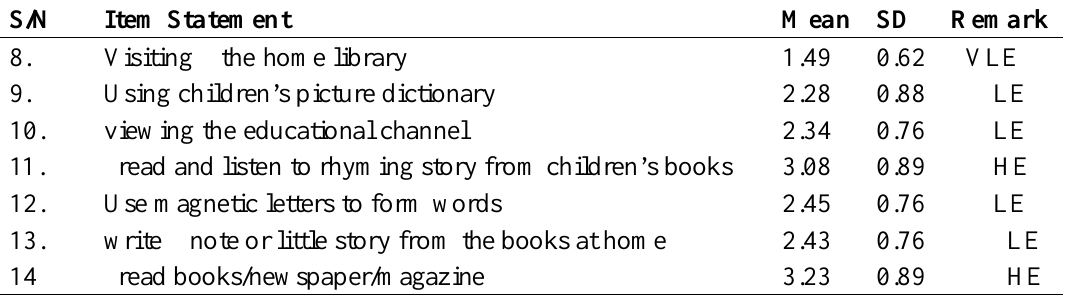
Table 2: Mean analysis of extent of utilization of reading resources at homes. S/N